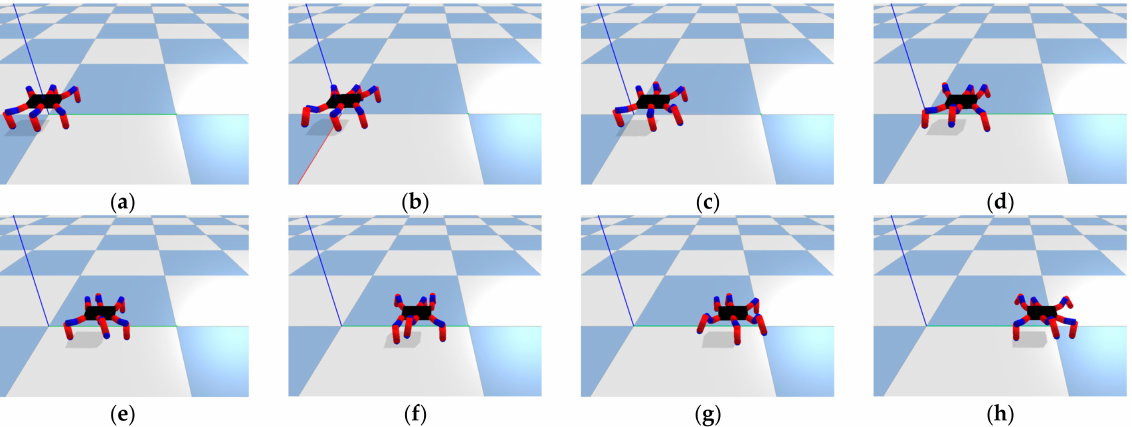
Figure 9. Speed-adaptive gaits of the hexapod robot trained in the hierarchical framework for reinforcement learning. From ( a – h ), the robot walked in a fixed direction and the motion speed gradually increased to 0.6 m/s. As the speed increased, the hexapod robot gradually transitioned from a wave-like gait to a tripod-like gait, and the robot was stable enough not to fall.